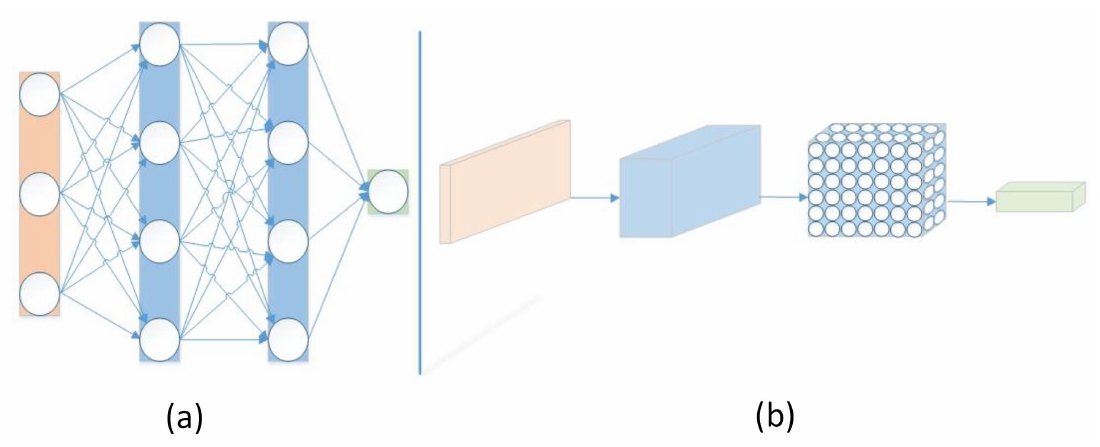
Figure 2. Neuron layouts in different types of neural networks. ( a ) Fully Connected Neural Network; ( b ) Convolutional Neural